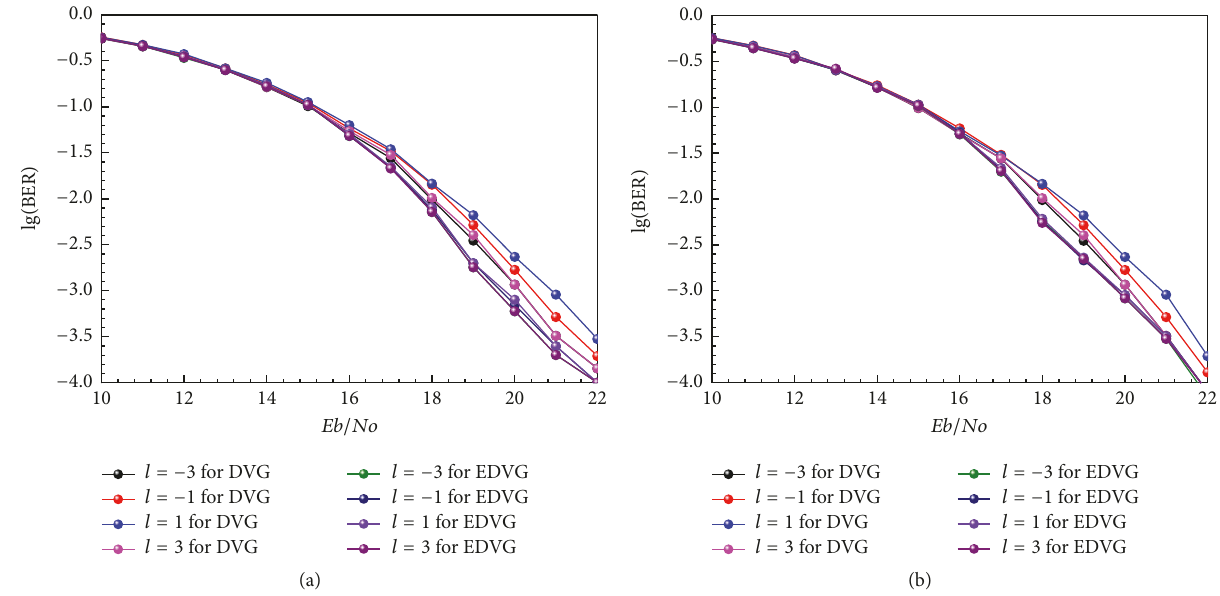
Figure 7: The error curves graph of the OAM optical communication system. (a) The error curves by using DVG and EDVG for demultiplexing, respectively. (b) The error curves by using DVG and EDVG for demultiplexing in the absence of channel